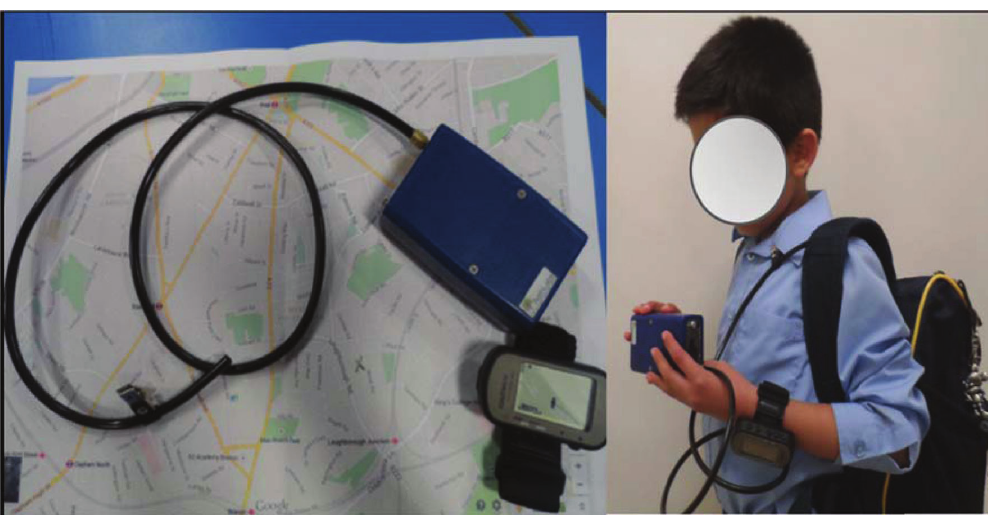
Figure 1: Micro-aethalometer and GPS used (left) and a child carrying a monitor and wearing the GPS watch